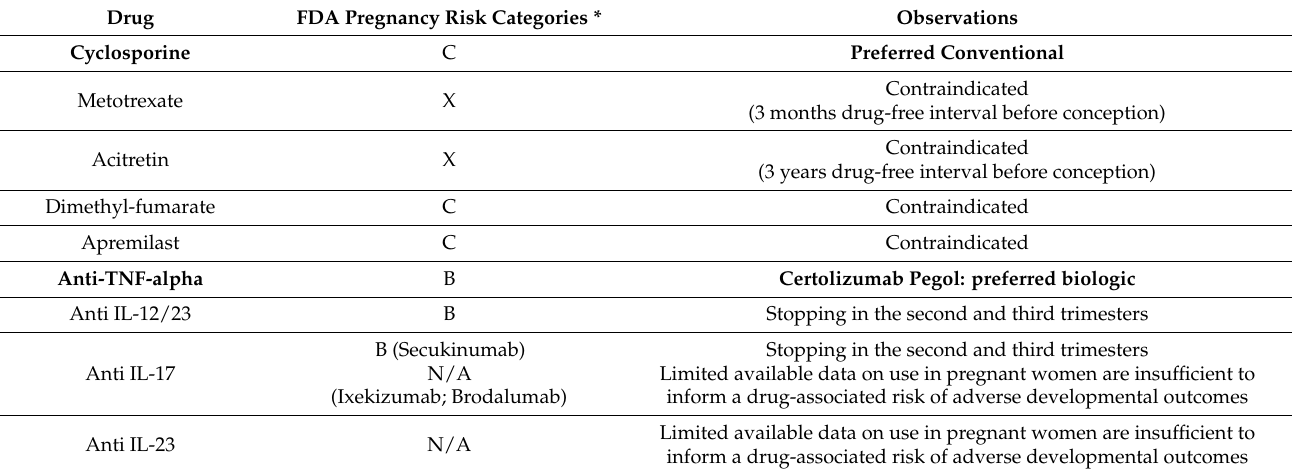
Table 1. Systemic treatment options for moderate-to-severe psoriasis during